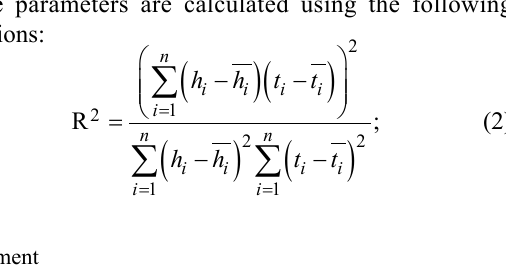
Table 2. Descriptive statistics of the variables used for the model development Parameter B (m) Mean Standard